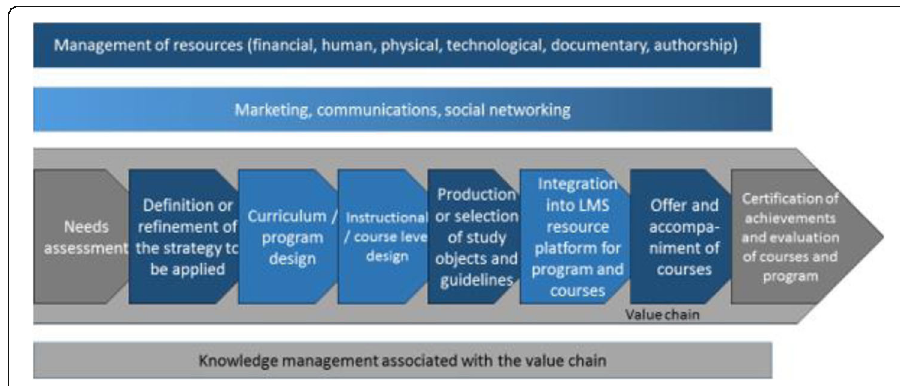
Fig. 4 Blended learning program and course value and support chain processes. Source: